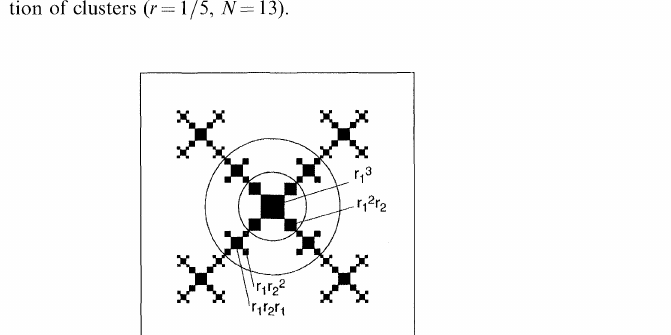
FIGURE 2 A Sierpinski carpet with hierarchical distribu- tion of clusters (r= 1/5, N= 13).